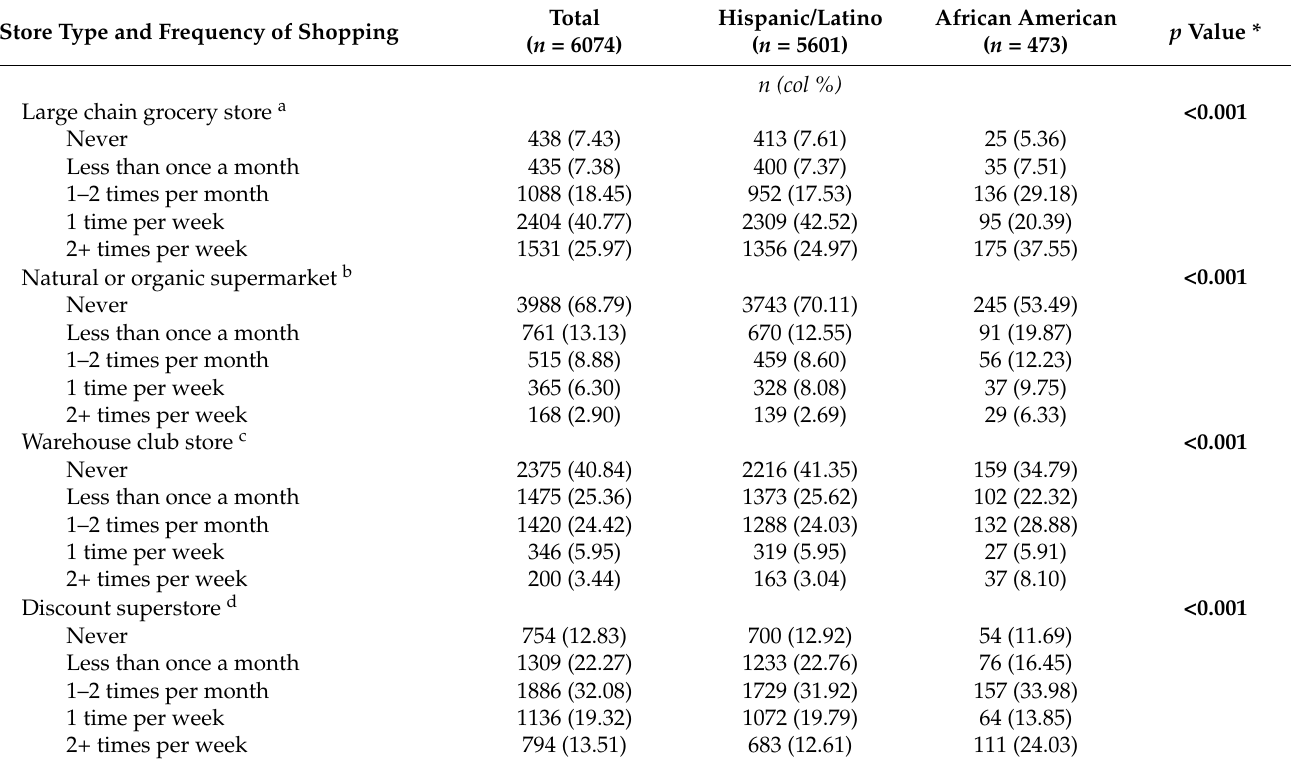
Table 2. Reported Fruit and Vegetable (FV) Food Shopping Behaviors of Brighter Bites Participants ( n = 6074) Stratified by Race/Ethnicity, Fall 2018 Parent baseline